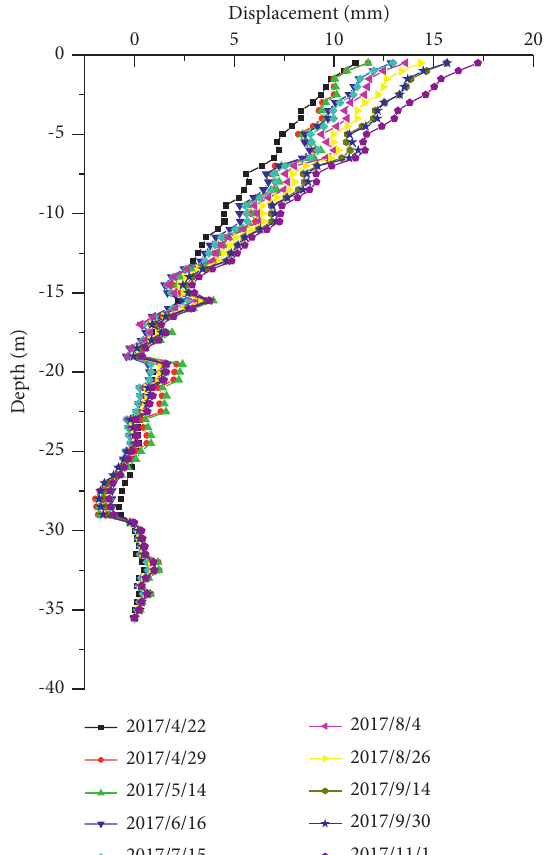
Figure 9: Displacement curve of 29# antislide pile at different depths during the earthquake.